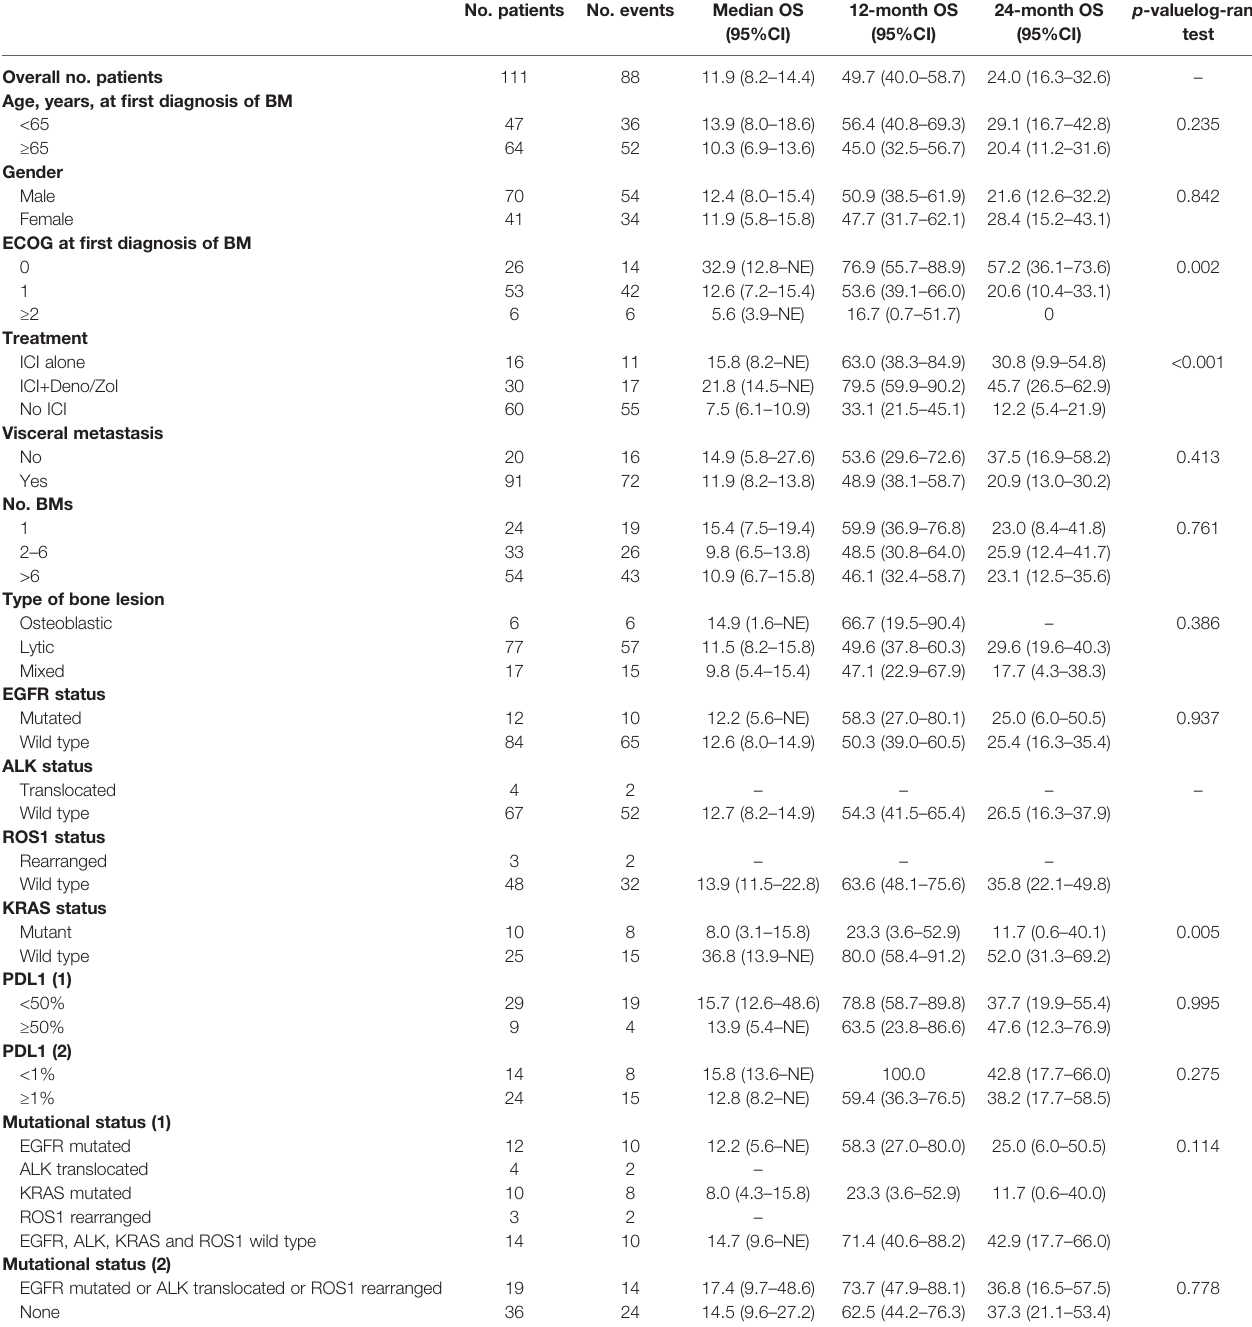
TABLE 3 | Univariable analysis of overall